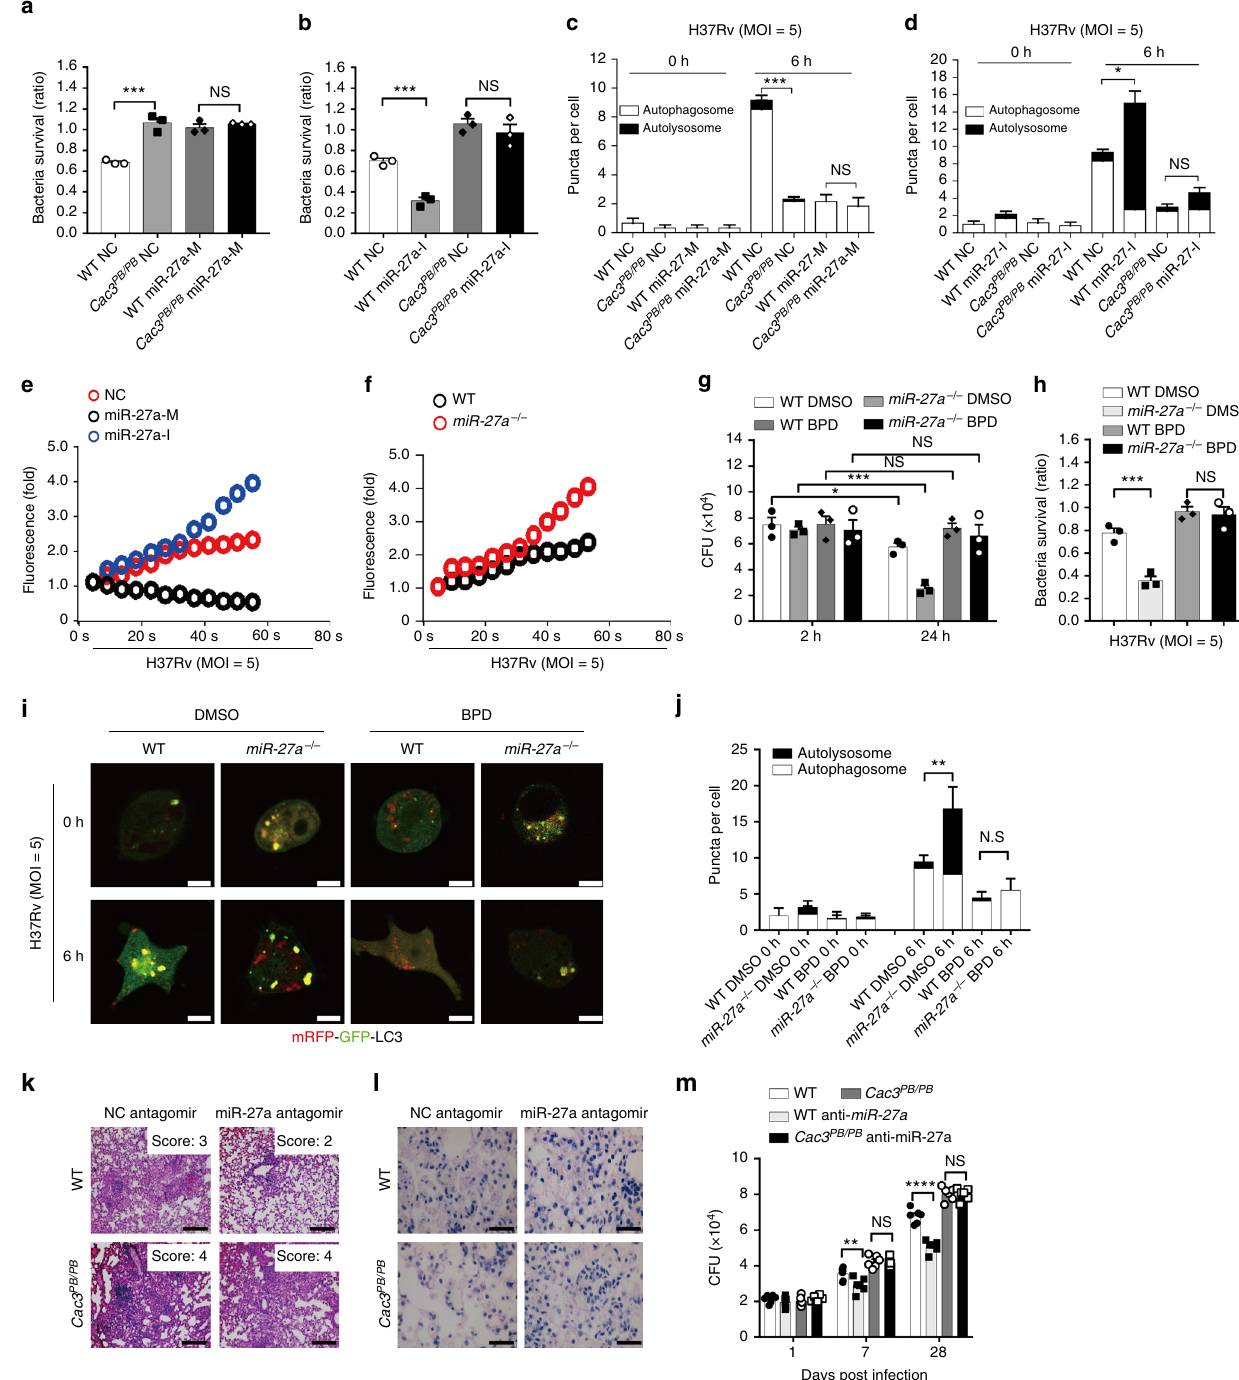
Fig. 6 miR-27a regulates Mtb infection via Cacna2d3/Ca 2 + . a , b Intracellular survival of WT or Cac3 PB/PB macrophages pretreated with ( a ) NC or miR-27a- M, ( b ) NC or miR-27a-I, and then infected with Mtb for 2 h and 24 h. c , d LC3 puncta from macrophages pretreated with NC and miR-27a-M ( c ) or miR-27a-I ( d ) then infected with Mtb . e , f Intracellular calcium fl uorometry assay of ( e ) NC, miR-27a-M or miR-27a-I-treated, or ( f ) WT or miR-27a -/- macrophages, and then infected with Mtb for 1 min. g , h CFU assay ( g ) and intracellular survival of Mtb ( h ) of macrophages pretreated with DMSO or Bepridin (BPD), and then infected with Mtb for 2 and 24 h. i , j Assay of ( i ) mRFP-GFP-LC3B spots or ( j ) numbers of LC3 puncta in macrophages of WT and miR-27a -/- mice pretreated with DMSO or BPD, and then infected with Mtb . Bar, 5 μ M. k , l FVB and Cac3 PB/PB mice treated with NC antagomir or miR-27a antagomir twice a week for 1 month after Mtb infection for 15 days, and then subjected to ( k ) H&E staining of mice lung, Scale bar, 100 μ m; ( l ) acid-fast staining of bacteria in the mice lung, Scale bar, 20 μ m; m CFU in mice lung. NS, not signi fi cant ( p > 0.05), * p < 0.05 and ** p < 0.01 by the unpaired t -test ( c , d , h , j ) or Mann – Whitney U- test ( a , b , g , m ). Data are representatives from three independent experiments with biological duplicates in each ( a , b , g , h , mean ± s.e.m. of n = 3 duplicates; c , d , j , m , mean ± s.e.m. of n = 6 duplicates) or representatives of three independent